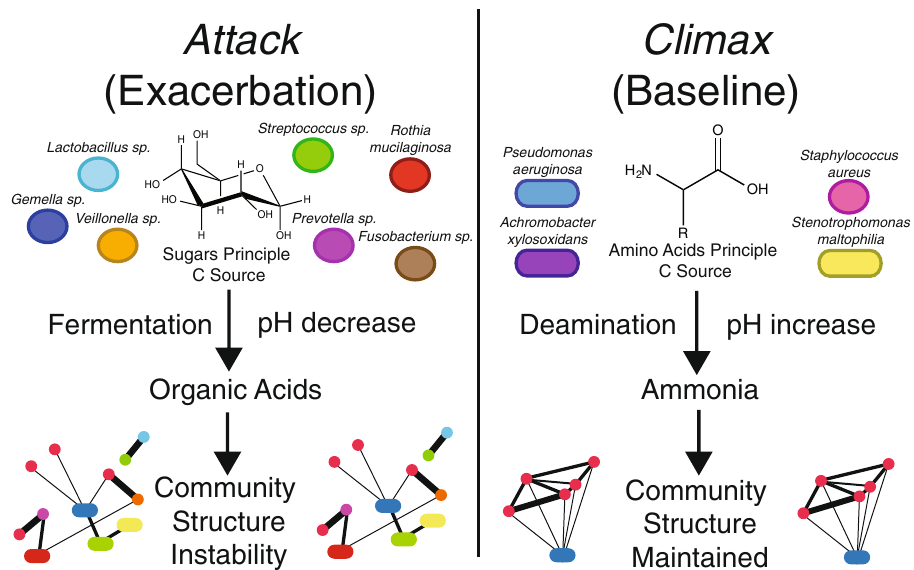
Fig. 6 The Climax and Attack Model (CAM) as inferred from co-occurrence network results from this study. Different communities containing fundamentally different physiology affect the surrounding environment differently, principally by changing the pH. This results in community stability during Climax community growth and instability during growth of the Attack community at